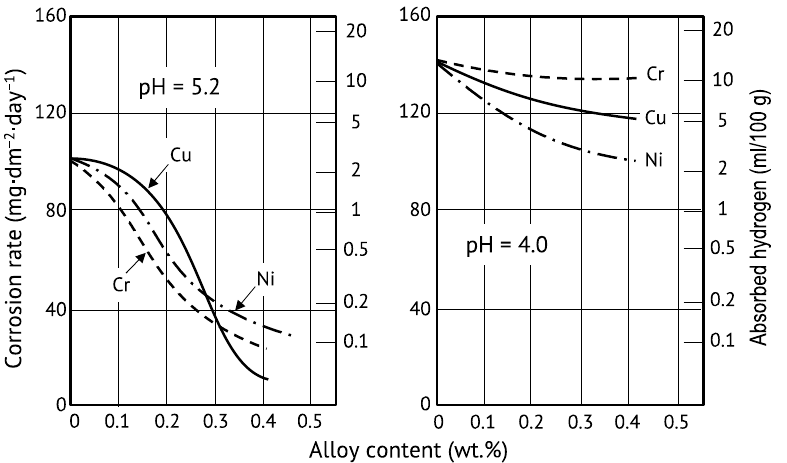
Figure 10. Influence of Ni, Cu, Cr alloy content on the corrosion rate and hydrogen absorption of low ‐ carbon line pipe steel exposed to a sour H 2 S containing environment (courtesy of K. Hulka, Niobium Products Company, Düsseldorf, Germany—based on data from [71]).